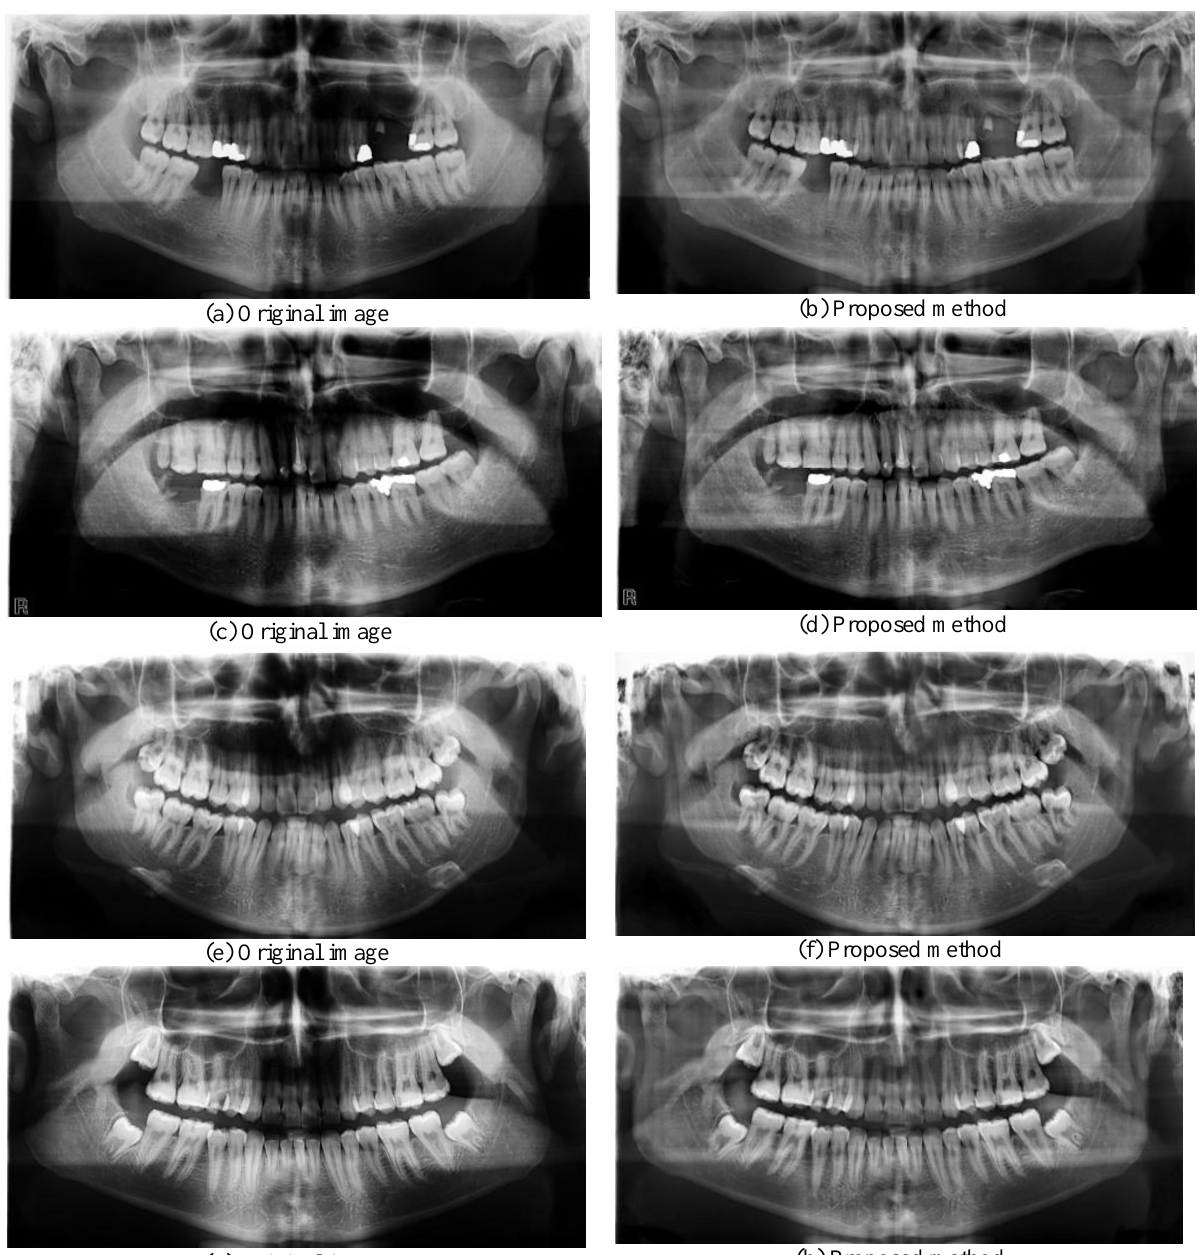
Figure 6. Image enhancement by our proposed